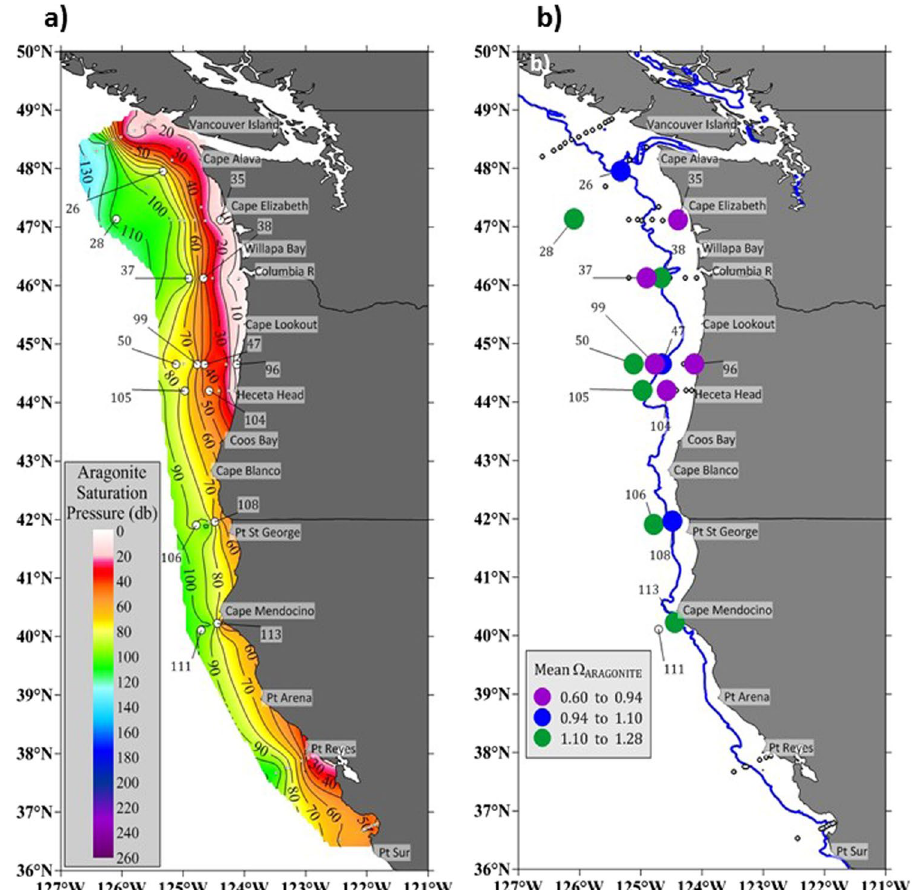
Figure 1. Ocean acidification (OA) conditions displayed as carbonate chemistry gradients along the US West Coast (Washington-Oregon-California). ( a ) OA is represented as the depth of aragonite saturation state ( Ω ar ), with the Ω ar isocline of 1. ( b ) Along these carbonate gradients in the California Current Ecosystem, biological samples were taken at selected stations (numbers) with in situ Ω ar conditions corresponding to mean Ω ar in the upper 100 m water column (filled circles, mean value ranges indicated in legend). Blue line indicates 200 m isobaths delineating coastal region of low Ω ar conditions on the shelf and offshore with higher Ω ar . The figure was created using Surfer 13 Golden Software